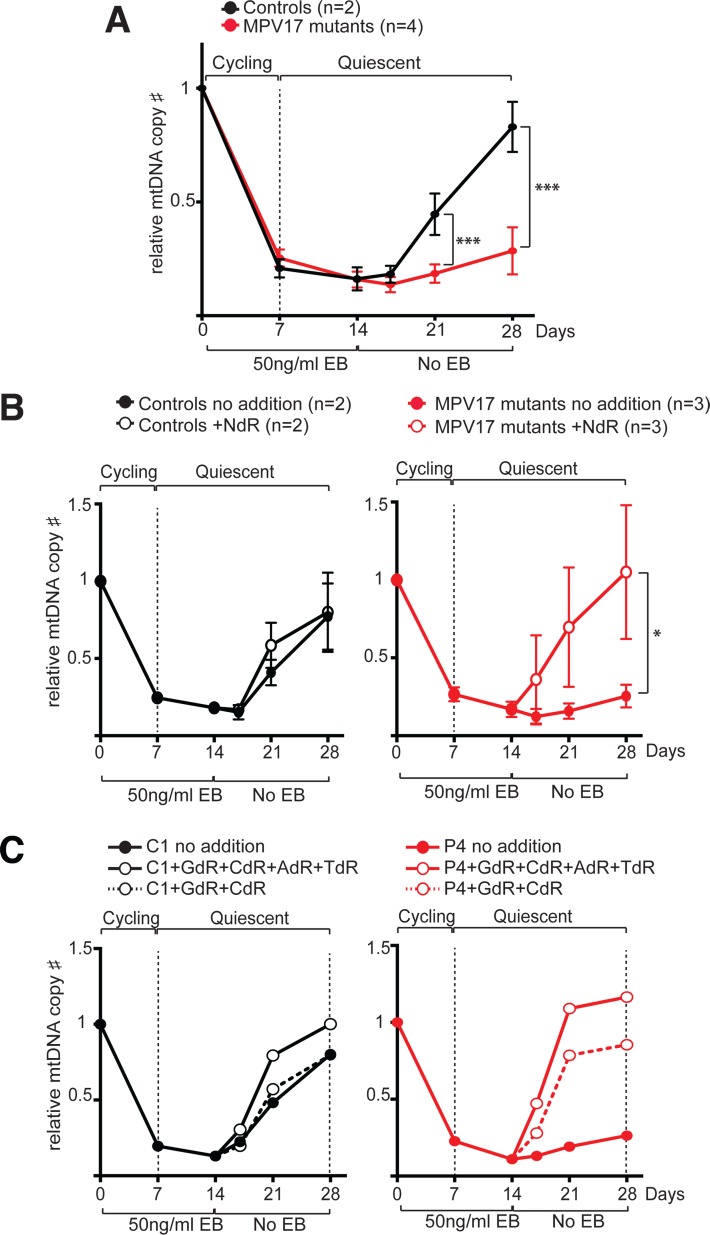
Deoxynucleoside supplementation enables full mtDNA recovery in MPV17-deficient fibroblasts after drug-induced transient depletion.(A) Slow recovery of mtDNA copy number in quiescent MPV17-mutant fibroblasts after depletion with ethidium bromide (EB). Two control (black) and four MPV17 patient-derived cell lines (red) were tested in two or three independent experiments. (Student’s t test: ***P<0.001) (B) MtDNA recovery in control (black) and MPV17-deficient fibroblasts (red) with or without deoxynucleoside supplementation (open and closed circles, respectively) of 100 μM AdR, CdR, and GdR. Data are expressed as mean ± SEM of two control and three MPV17 patient-derived cell lines, tested in two independent experiments (Student’s t test: *P<0.05). (C) MtDNA copy number was monitored via Q-PCR during and after ethidium bromide (EB)-induced mtDNA depletion (as per Fig 5B). C1 –control (black) and P4 MPV17-deficient fibroblast (red), with or without (open and closed circles, respectively) 50 μM of the indicated deoxynucleosides.